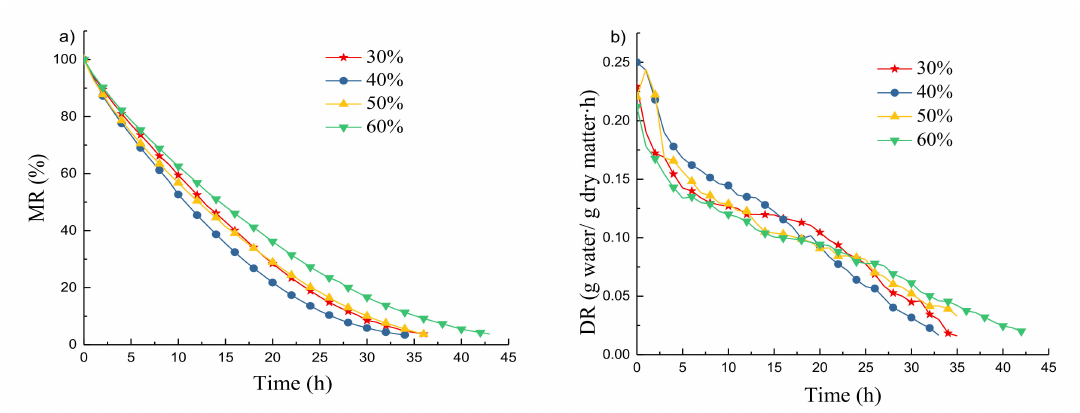
Figure 7. Variations of the moisture ratio ( a ) and drying rate ( b ) with drying time at a di ff erent relative humidity of drying